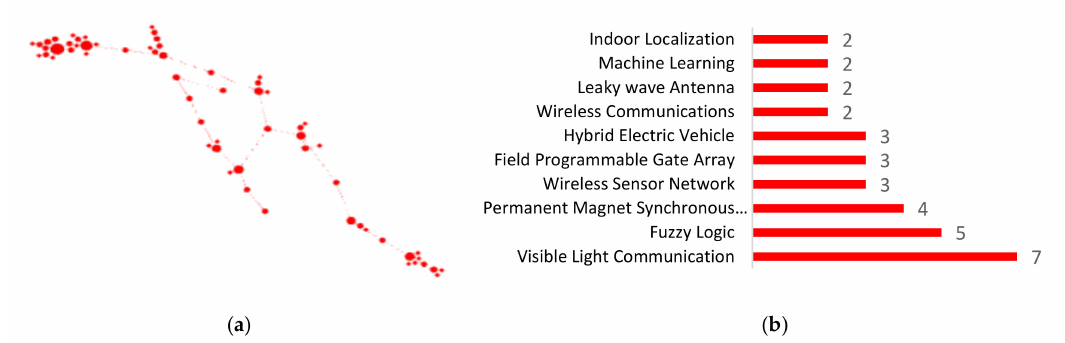
Figure 18. Representation of the Visible Light Communication community: ( a ) Isolated distribution of publications. ( b ) Keywords of the